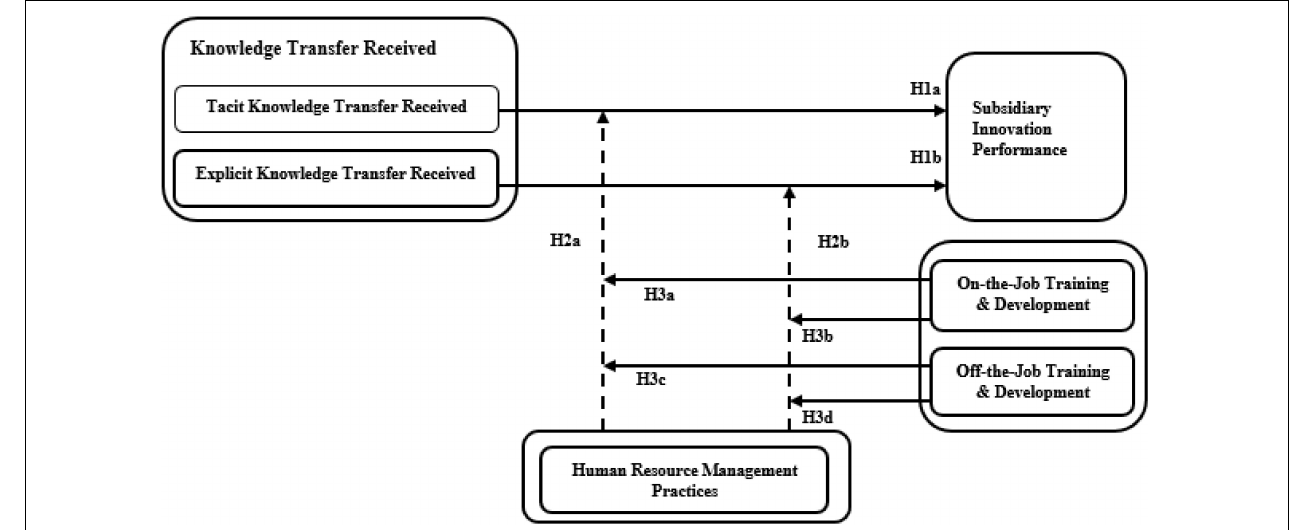
FIGURE 1 | Logical